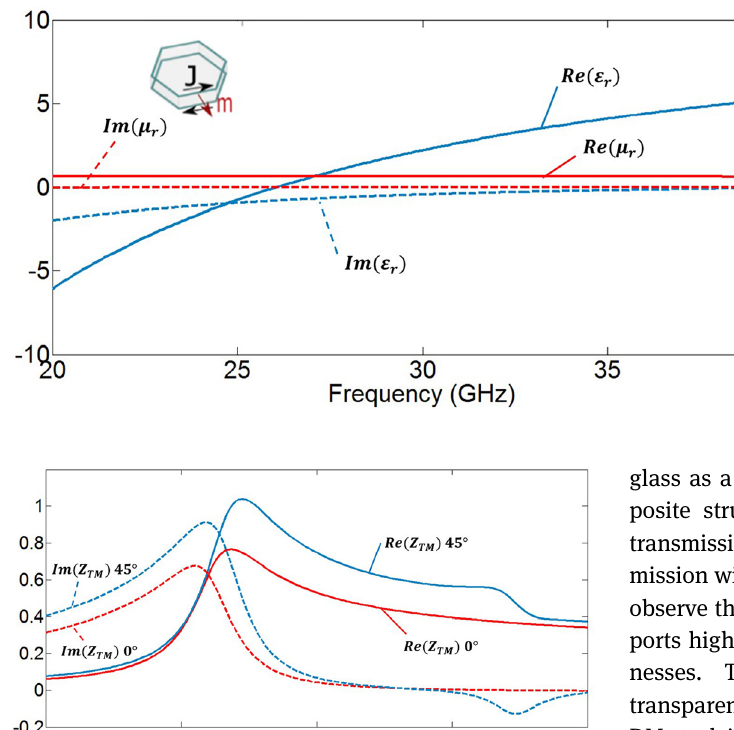
Figure 6: Normalized effective impedance of the meta-glass (i.e., ) ) for 45 ° to the normal and (cid:4) ( Z Vacuum Z TM (cid:1) Z Meta − glass TM TM